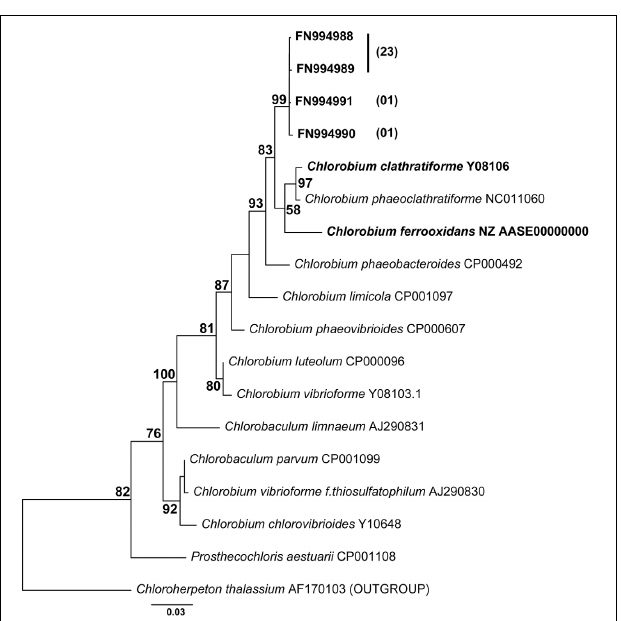
FIGURE 6 | Phylogeny of the photoferrotrophic enrichment culture based on nearly complete 16S rRNA gene sequences and maximum likelihood analysis. Among the retrieved sequences 80% formed a well-defined cluster within the Chlorobia (25/31 clones), phototrophic green sulfur bacteria; the rest of the sequences were most closely related to uncultivated Acidobacteria (5/31 clones). Numbers in brackets signify the number of clones possessing the same sequence. Bootstrap values > 50% for 1000 replications are shown.